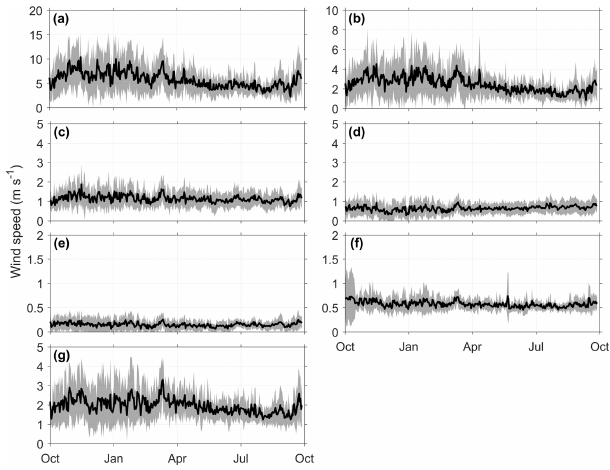
Figure 6. Annual mean daily wind speed for 11 water years from 1 October 2005 to 30 September 2016 at MCRB stations: (a) Cen- tennial Ridge, (b) Fisera Ridge, (c) Vista View, (d) Upper Clearing, (e) Upper Forest, (f) Level Forest, and (g) Hay Meadow. The line represents the annual mean and the shaded area represents the stan- dard deviation of the 11-year daily wind speed.